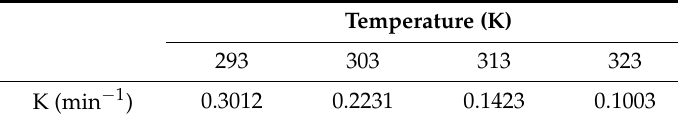
Table 2. The effect of temperature on reaction